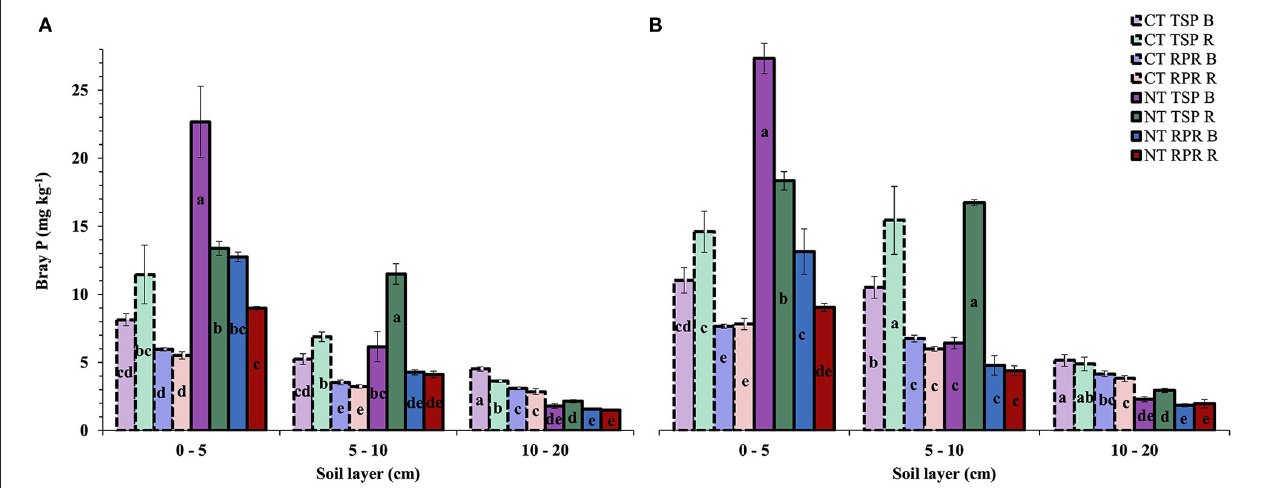
FIGURE 1 | Phosphorus availability (Bray-1) in three layers of a very clayey Oxisol under different soil tillage systems and phosphate fertilization management after 14 years/crops (A) and 17 years/crops (B) of crops. Letters compare treatments in the same soil layer according to the LSD test (P < 0.05). NT, no tillage; CT, conventional tillage; TSP, triple superphosphate; RPR, reactive phosphate rock; B, broadcast; R, row.